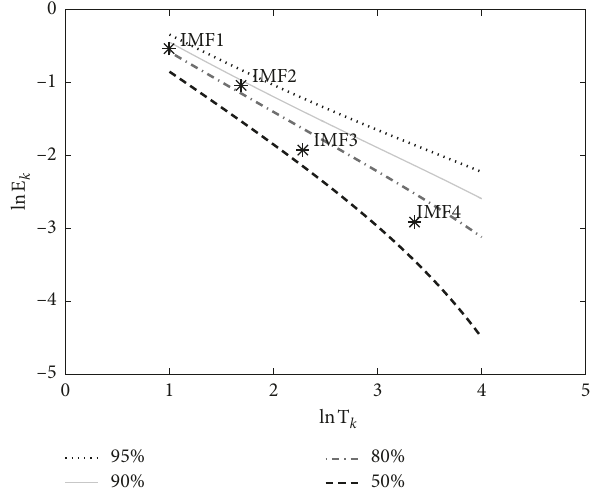
Figure 5: A significance test for the IMFs (IMF1–IMF4) of WD anomaly during the period 1961–2009 in the upper reach of the YZRB.